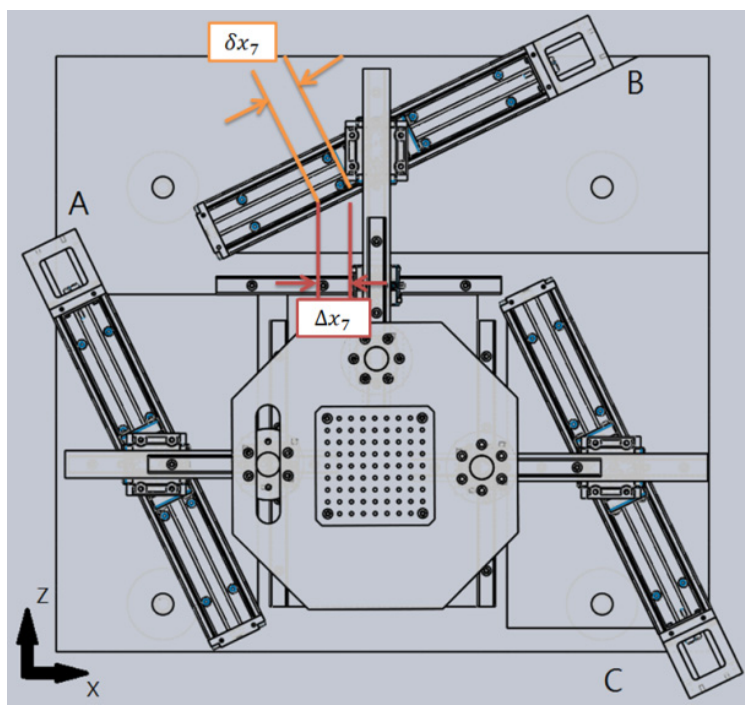
Figure 12. Ballscrew B motion along the X-axis with translation error. Similarly, the ballscrew motion error δ y and platform feed error is illustrated in 3 Figure 13. When the mechanism is designed with a tilt-drive angle of 25.84 ◦ and the ballscrew motion error of 0.5 µ m ( δ x3 ), this results in a feed error of 0.242 µ m ( ∆ y 3 ) for the platform, which is a reduction to 48% of the ballscrew motion error. If a machine is directly driven with the ballscrew with a motion error of 0.5 µ m, it will have a feed error of at least 0.5 µ m. That is, the designed mechanism has only about 50% of the error that the direct-driven mechanism has.